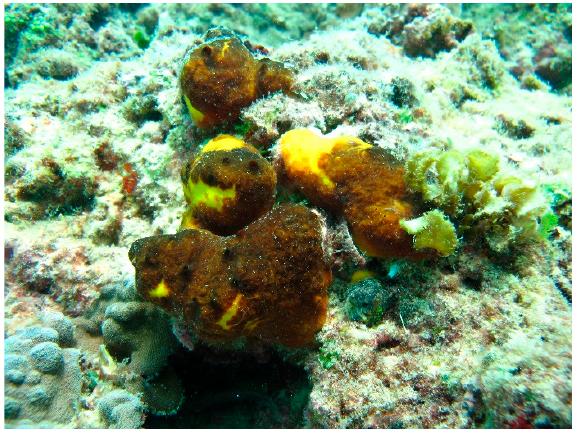
Figure 1. Aaptos suberitoides underwater at Mot Island in Nha Trang Bay (Photo: Thai Minh Quang).